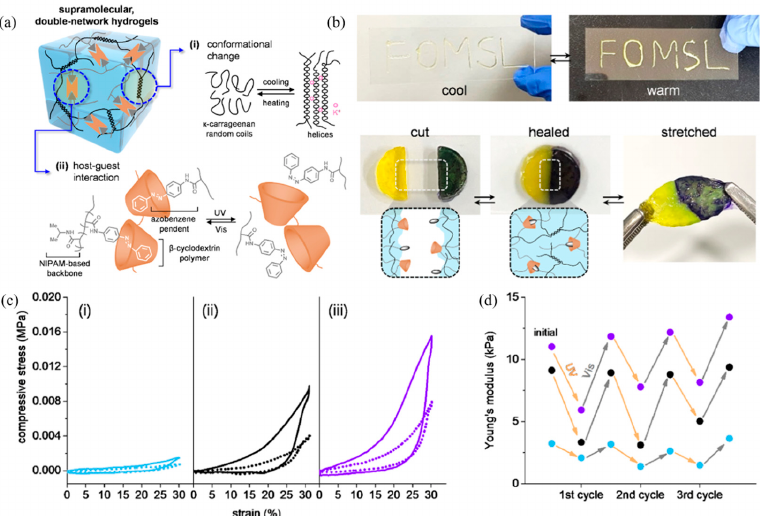
Figure 25. The self-healing of the supramolecular network in hydrogel; ( a ) the combination of reversible chains and host–guest interaction to obtain supramolecular networks, ( b ) demonstration of the self-healing process, ( c ) compressive stress–strain curves of (i) ncSNH, (ii) ncDNH, and (iii) ncDNH at 36.5 ◦ C before and after UV irradiation (solid and dotted), and ( d ) Young’s modulus changing the sample at various cycles of UV and visible light irradiation [116]. Adapted with permission from [116]. Copyright 2021 American Chemical Society.